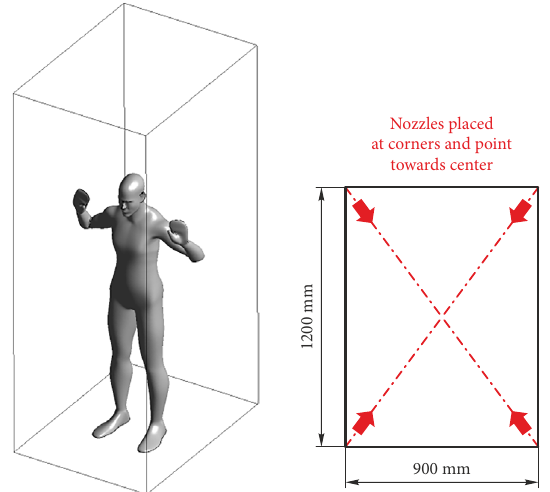
Figure 1. Isometric view (left) and plan view (right) of prefabricated sanitising chamber